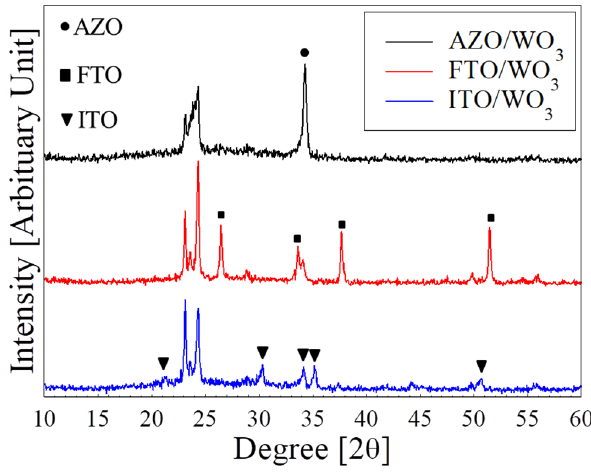
Figure 1. The XRD patterns of the as ‐ deposited WO 3 films on different TCO substrates.